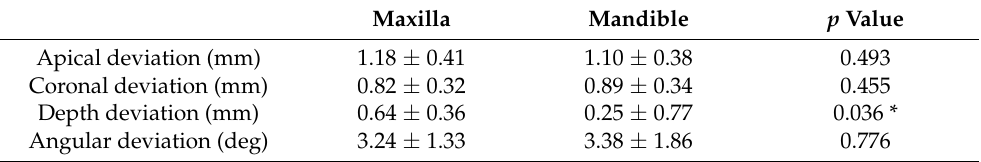
Table 4. t -test specific to the influence of arch type on the bone density and the deviation values (N = 52). Maxilla Mandible p Value Apical deviation (mm)